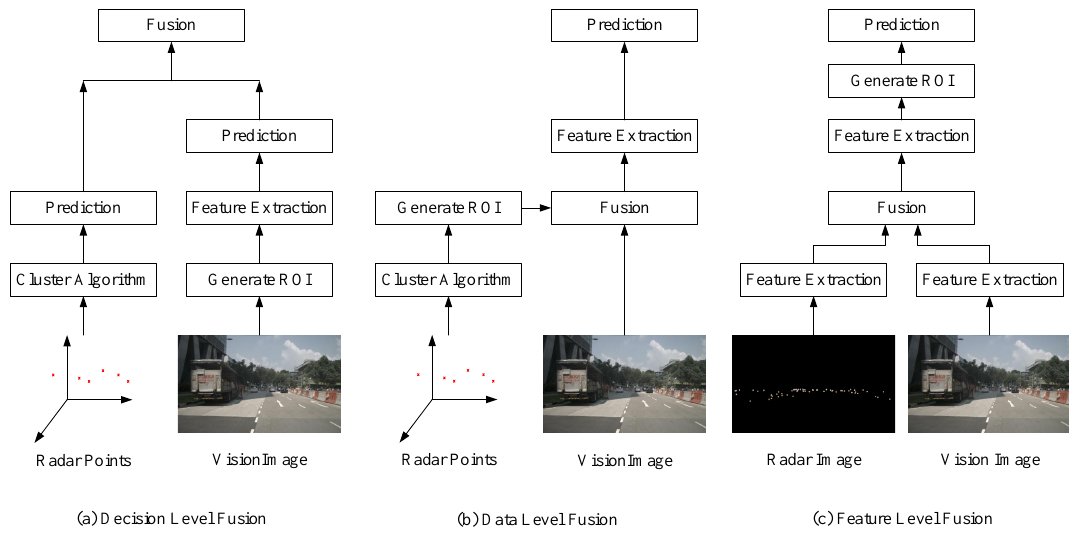
Figure 2. Three different fusion schemes using mmWave radar and vision sensor for obstacle